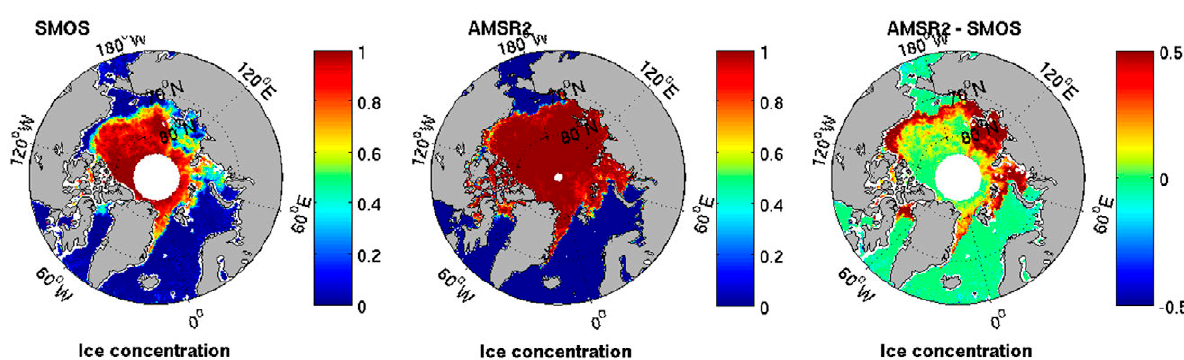
Fig. 11. – Sea ice thickness measured by SMOS from 2 to 5 Nov. 2014 (top left), measured by AMSR2 on 3 Nov. 2014 with ASI algorithm (top right) and the differences between them